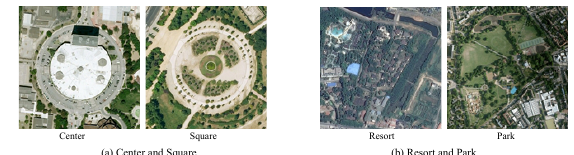
Figure.10 Legend of Center and Square, Resort and